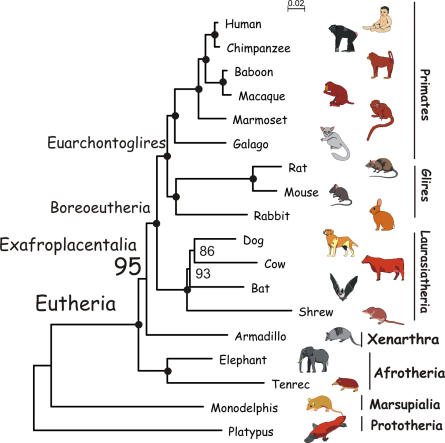
ML Phylogenetic Tree of MammalsThe topology and branch lengths shown here are based on concatenated alignments of coding exons (68,262 codons). Branch lengths are scaled to the number of substitutions per site. Bootstrap support values are indicated at each node, with solid-color dots indicating 100% support.